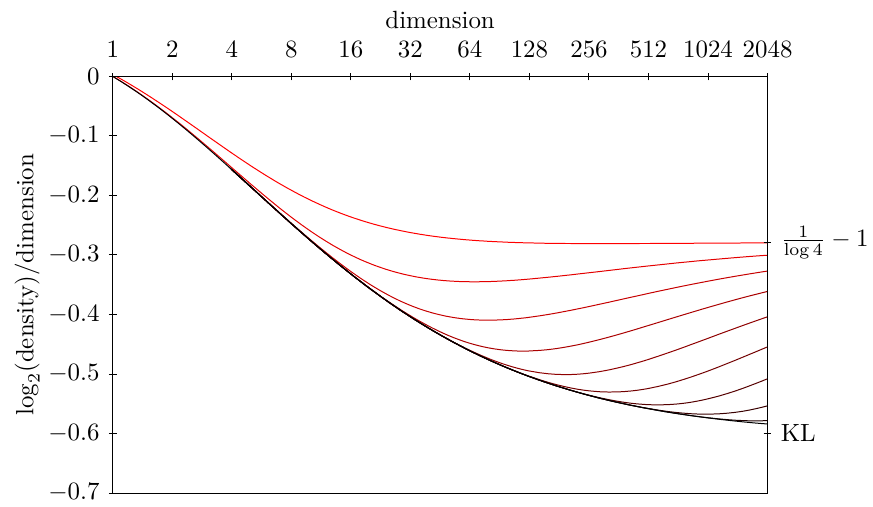
Figure 17 . Density bounds based on N = 1 , 2 , 4 , 8 , . . . , 512 (colored red through black).